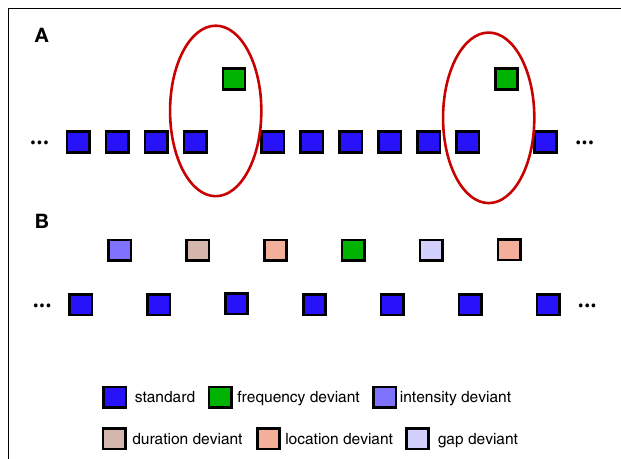
FIGURE 2 | Sequences used during data collection. (A) Example of oddball sequences used to collect Dataset 1. An oddball sequence with a 500 Hz standard stimulus (85% of trials) and a 600Hz deviant stimulus (15% of trials) was used to collect Dataset 1. Only data from deviant trials and the standard trials immediately preceding them were used in the classification analyses (illustrated using red circles). Each block contained a total of 1000 trials. (B) Example of “optimal” MMN sequences used to collect Dataset 2. An alternative sequence structure utilizing 5 different types of deviant stimuli can be used to reduce the overall amount of time required to collect MMN responses (Naatanen et al., 2004; Duncan et al., 2009). Here, all standard and deviant trials are utilized in the classification analysis. Each block contained a total of 600